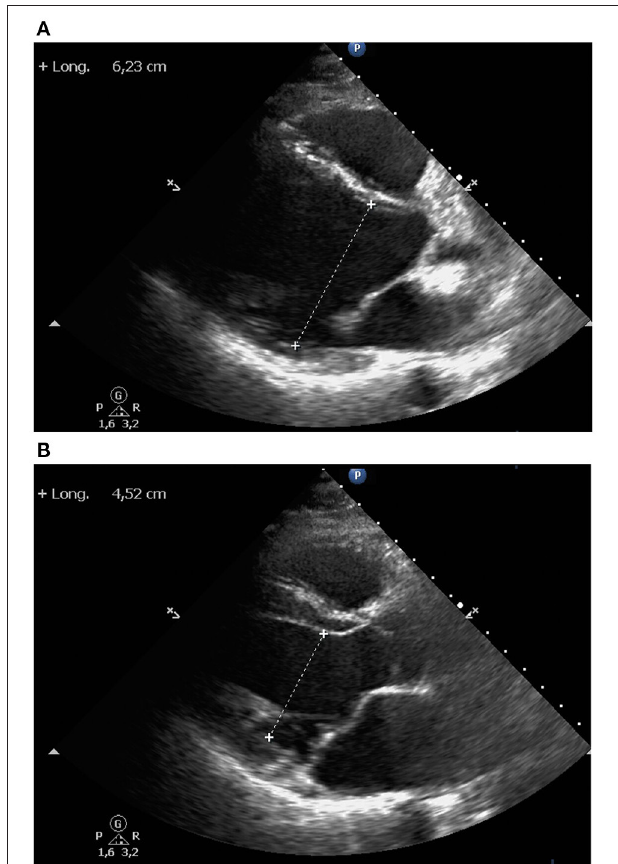
FIGURE 2 | Echocardiography. Parasternal long axis view showed mild left ventricular enlargement, both left ventricular end-diastolic (A) and end-systolic (B) diameters. Right ventricle, ascending aorta and left atrium were of normal size. Interventricular septum and posterior left ventricular wall had normal thickness. No pericardial effusion was